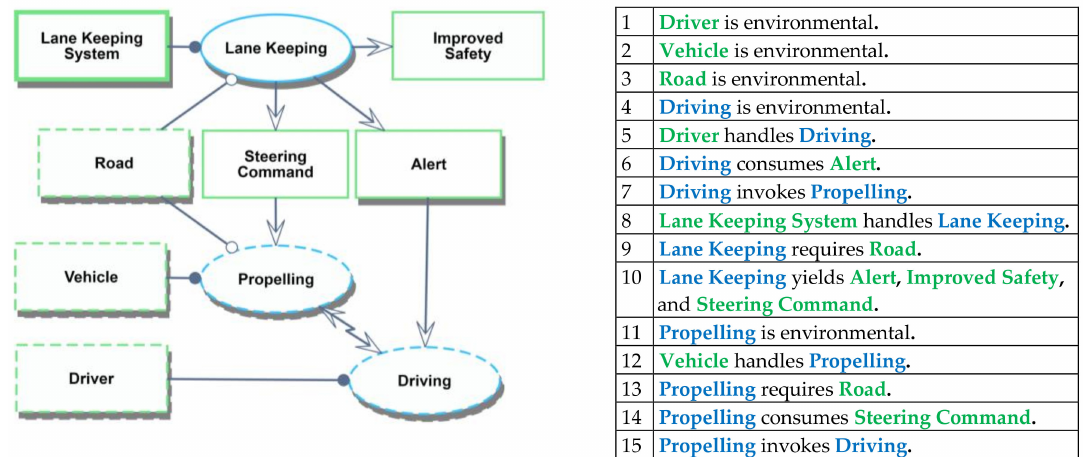
Figure 2. OPM model (OPD on the left, OPL on the right) of a Lane Keeping System , loosely based on [32]. The system handles a Lane Keeping function that provides Improved Safety . Lane Keeping generates Alerts that inform the Driving process, and Steering Commands that affect the Vehicle ’s Propelling function. The Road constitutes an instrument for both Propelling and Lane Keeping . Driving and Propelling affect each other regardless of the Lane Keeping System